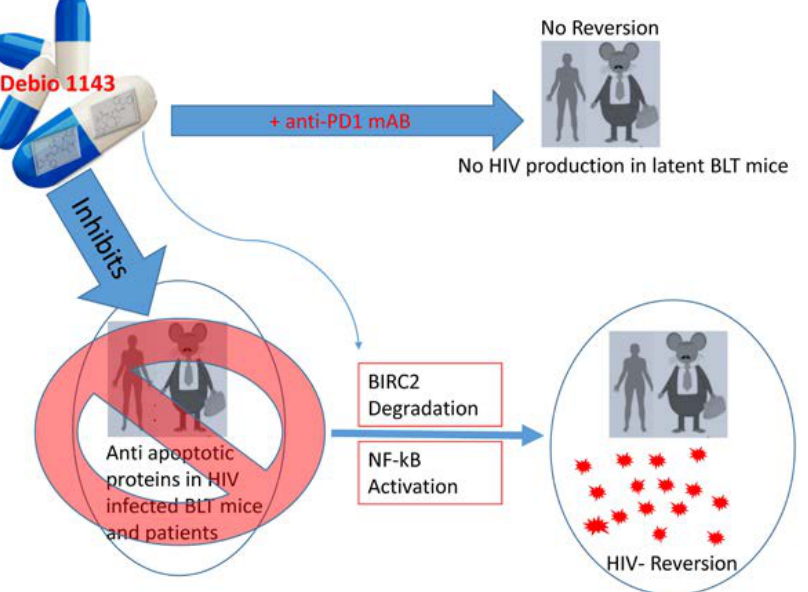
Figure 4. Inhibition of anti-apoptotic proteins reverses HIV latency. Debio 1143 (an IAP inhibitor) inhibits anti-apoptotic proteins such as BIRC2, which activates NF- κ B-mediated HIV reversal. HIV latency can be markedly reversed in ART-treated BLT mice and human subjects when treated with Debio 1143. On the other hand, Debio 1143, when combined with anti-PD1 monoclonal antibody (mAb), can reduce HIV production and latency reversion in BLT humanized mice in most tissues (spleen, lymph nodes, liver, lungs, and thymic organoids). The dual role of chemical agents in HIV reversal/maintenance is thus intriguing and warrants further